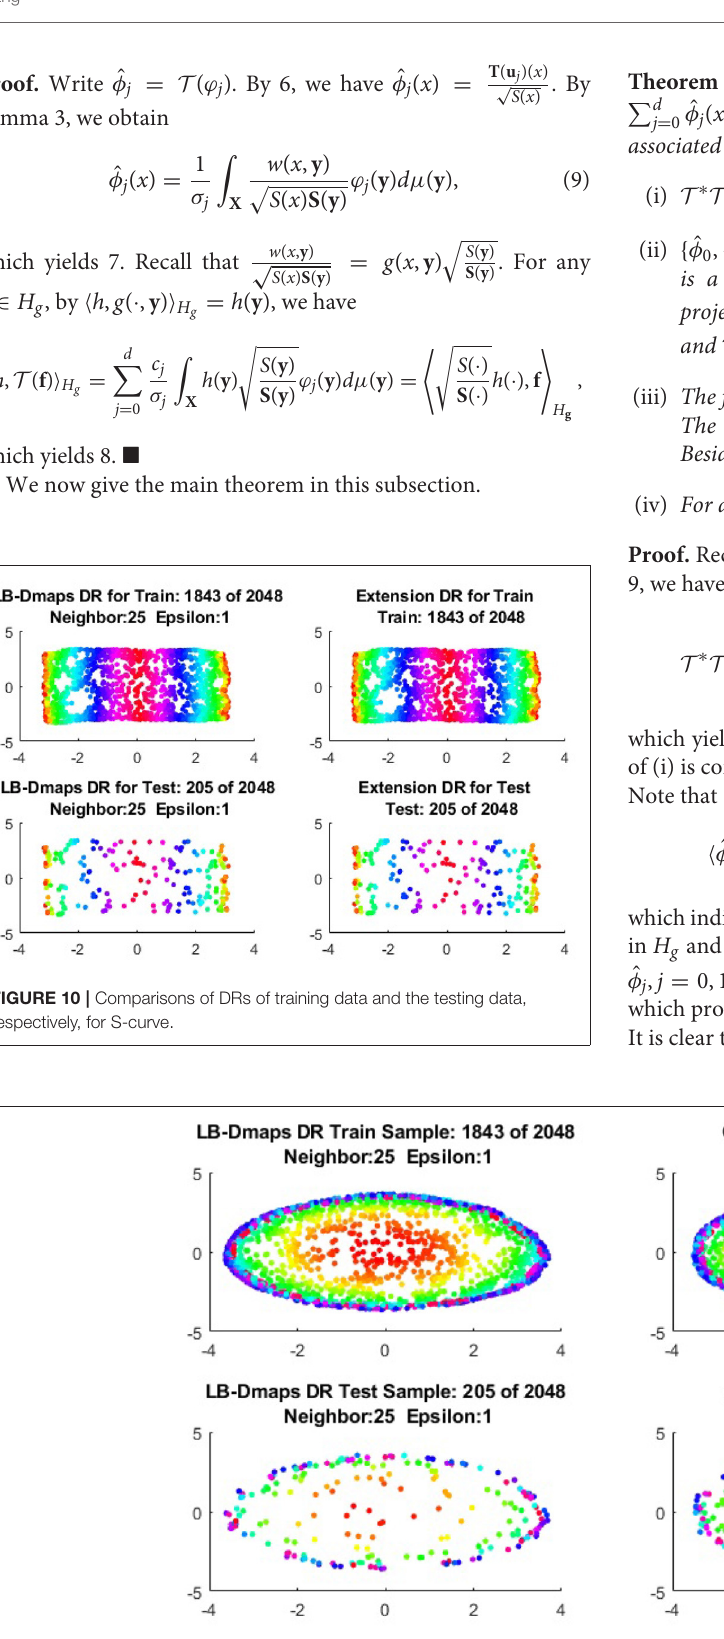
FIGURE 11 | Comparisons of DRs of training data and the testing data, respectively, for Punched